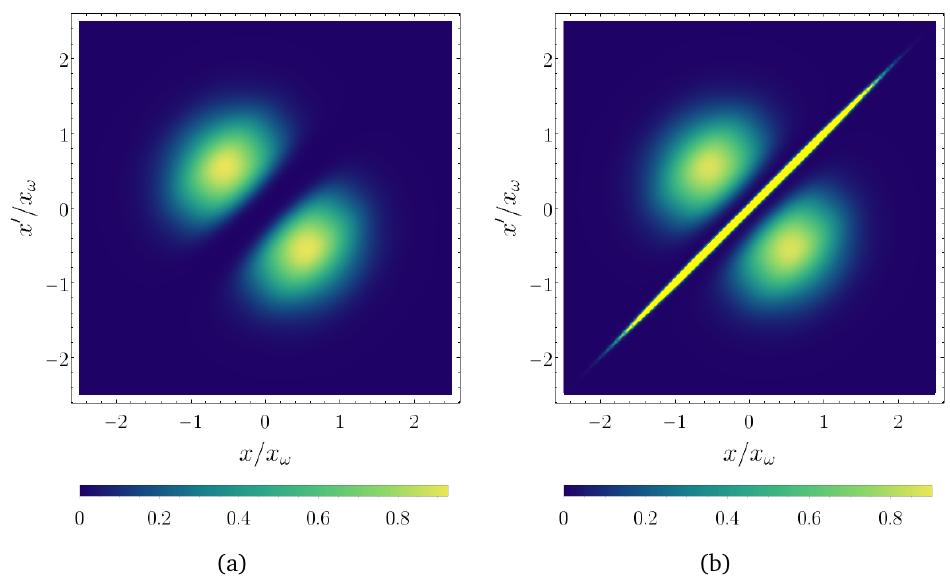
( x , x ′ ) in units of x − 2 Figure 3: a) Joint density distribution D , for two fermions of ω aa ( x , x ′ ) , kind a at positions x and x ′ simultaneously. b) Joint density distribution D ab in units of x − 2 , for finding a fermion of kind a at position x and one of kind b at ω position x ′ simultaneously. Both densities were obtained from the numerical solution for λ x ω = 30. Details of the calculations are given in Appendices B and C.